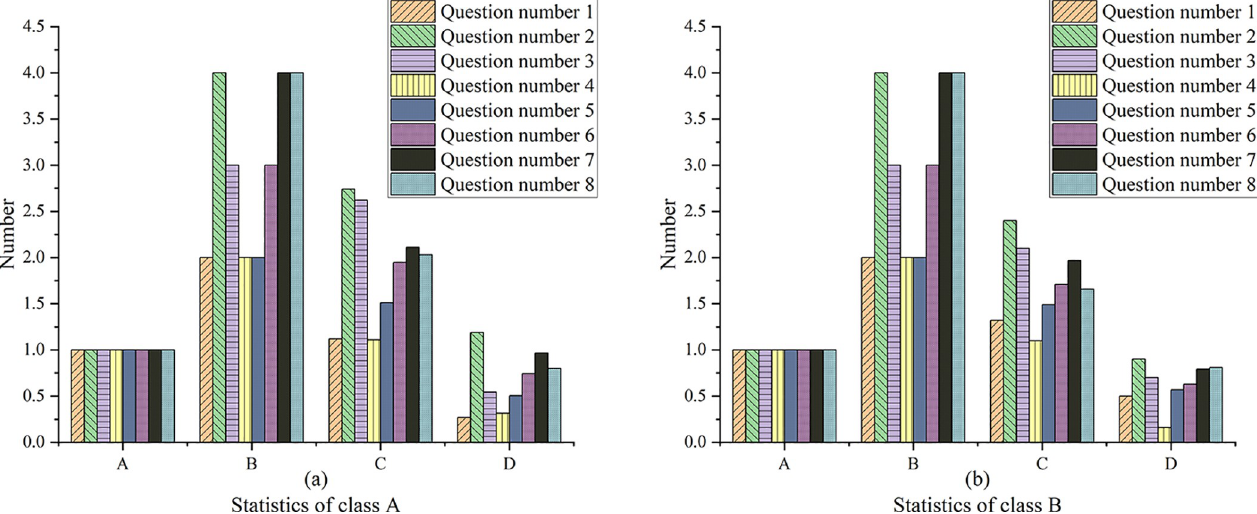
Fig 17. Questionnaire survey data of two classes. Note: A~D in the figure represent minimum value, maximum value, mean value, and standard value, respectively.